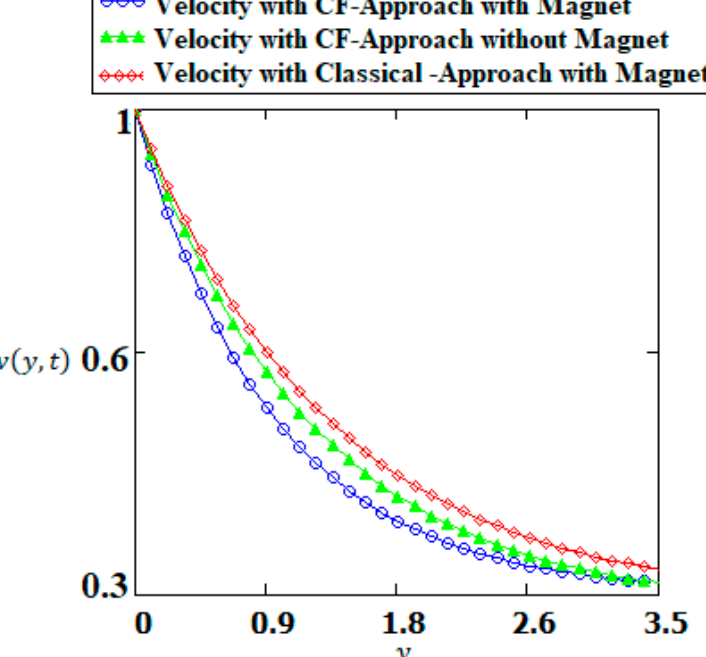
Energies 2022 , 15 , x FOR PEER REVIEW Figure 6. Comparison of velocity field depicted from Equation (19) with M = 0 and δ (cid:54) = 1, Equation (19) Figure 6. Comparison of velocity field depicted from Equation (19) with 𝑀 (cid:3404) 0 and 𝛿 (cid:3405) 1 , Equa ‐ for M (cid:54) = 0 and δ (cid:54) = 1, Equation (19) for M (cid:54) = = 0 and δ = 1. tion (19) for 𝑀 (cid:3405) 0 and 𝛿 (cid:3405) 1 , Equation (19) for 𝑀 (cid:3405) 0 and 𝛿 (cid:3404) 1 .